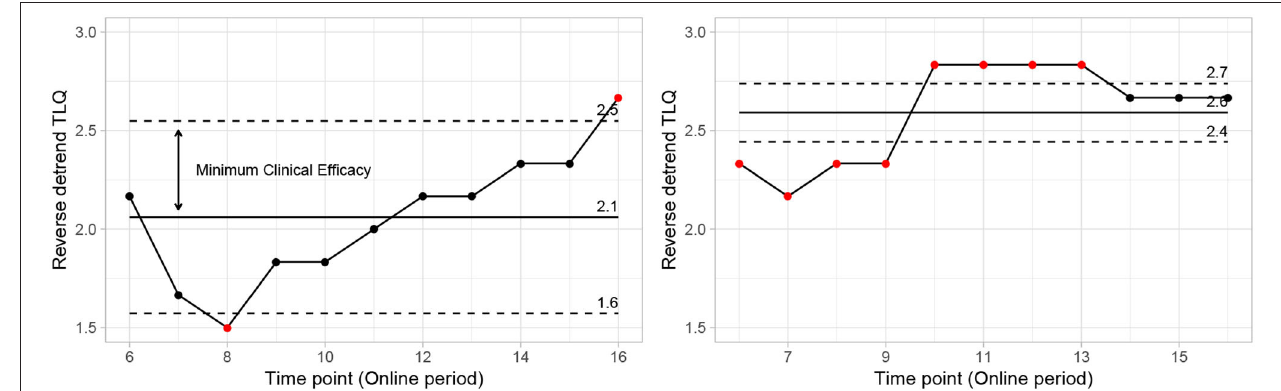
FIGURE 8 | Control chart showing mean points and natural limits from data (PEI left side vs. “SP” right side). Points outside limits reflect fundamental changes in expected behavior. Reflecting significant changes in the average behavior of the reverse detrend TLQ. On the other hand, the variation around the mean and internal to the limit shows the usual behavior with small changes due to